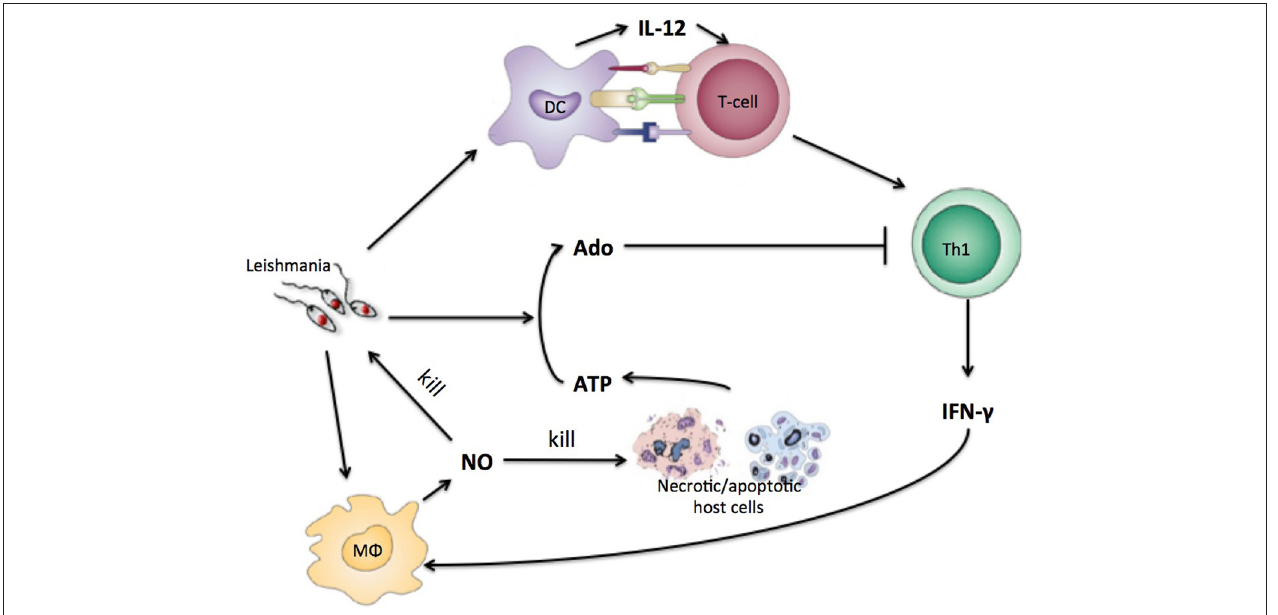
FIGURE 1 | Simplified view of the immune response to Leishmania infection with purinergic metabolism. Leishmania antigen will be presented to naïve T-cells by DC. T-cells will differentiate into Th1-cells that will produce INF-gamma. IFN-gamma will instruct macrophages to produce NO that kills parasite and host cells. Necrotic host cells releases high concentrations of ATP and other nucleotides that are converted by leishmania to adenosine which inhibits Th1